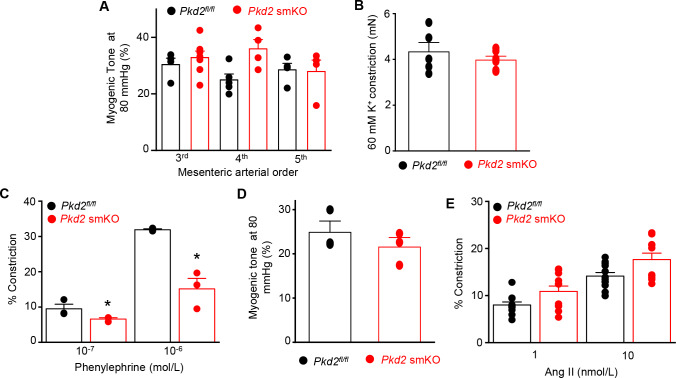
Myocyte PKD2 knockout attenuates phenylephrine-induced vasoconstriction, but does not alter pressure or angiotensin II-induced vasoconstriction in mesenteric arteries.(A) Mean myogenic tone at 80 mmHg illustrating that myogenic tone is similar in third-, fourth-and fifth-order mesenteric arteries and unaltered by PKD2 knockout (Pkd2fl/fl: 3rd n = 4; 4th n = 5; 5th n = 4 and Pkd2 smKO: 3rd n = 7; 4th n = 4; 5th n = 4). (B) Mean data for 60 mM K+-induced constriction in first-and second order mesenteric artery rings (Pkd2fl/fln = 5; Pkd2 smKO n = 6). (C) Mean data for phenylephrine-induced vasoconstriction in pressurized, endothelium-denuded 4th order mesenteric arteries (Pkd2fl/fl, n = 3 and Pkd2 smKO, n = 3). * indicates p<0.05 versus Pkd2fl/fl. (D) Mean myogenic tone at 80 mmHg in endothelium-denuded 4th order mesenteric arteries (Pkd2fl/fl, n = 3 and Pkd2 smKO, n = 3). (E) Mean data for angiotensin II-induced vasoconstriction in mesenteric arteries (Pkd2fl/fl, n = 11–12 and Pkd2 smKO, n = 10–11).